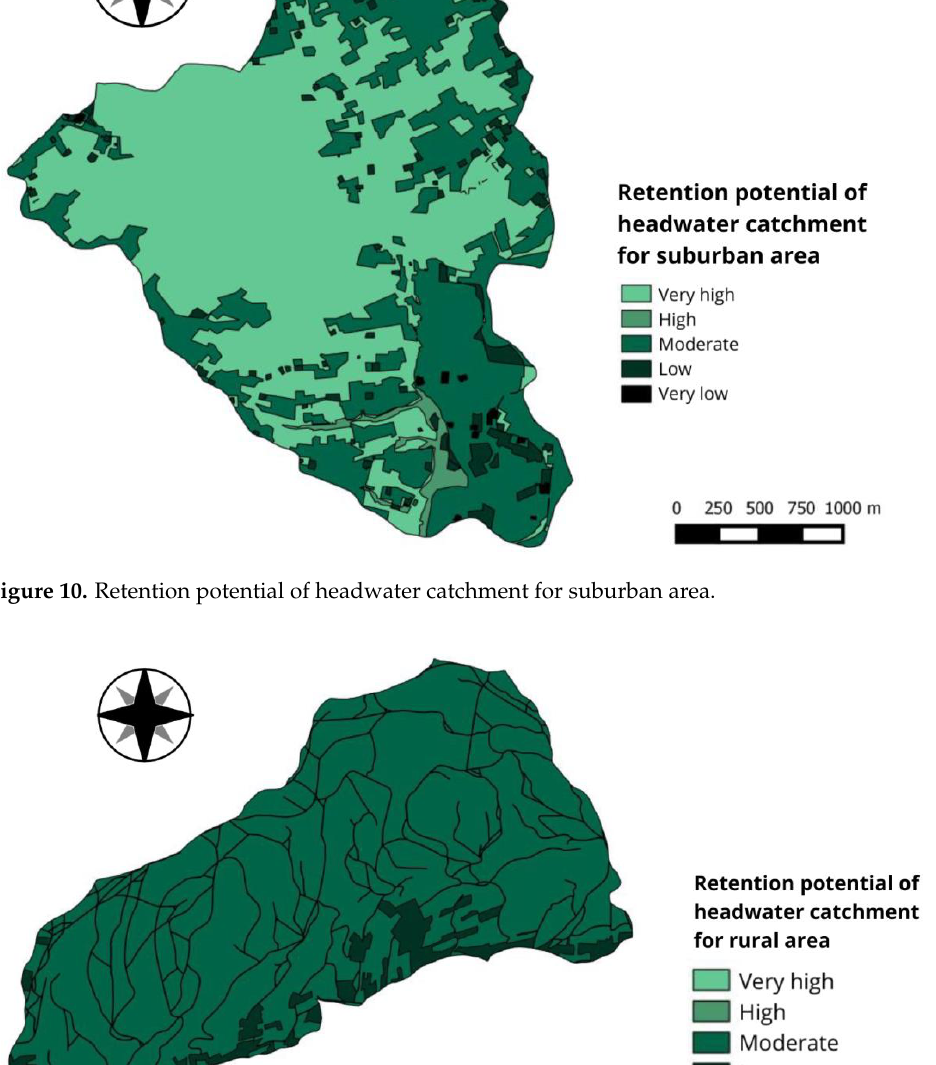
Figure 9. Retention potential of headwater catchment for urban area.